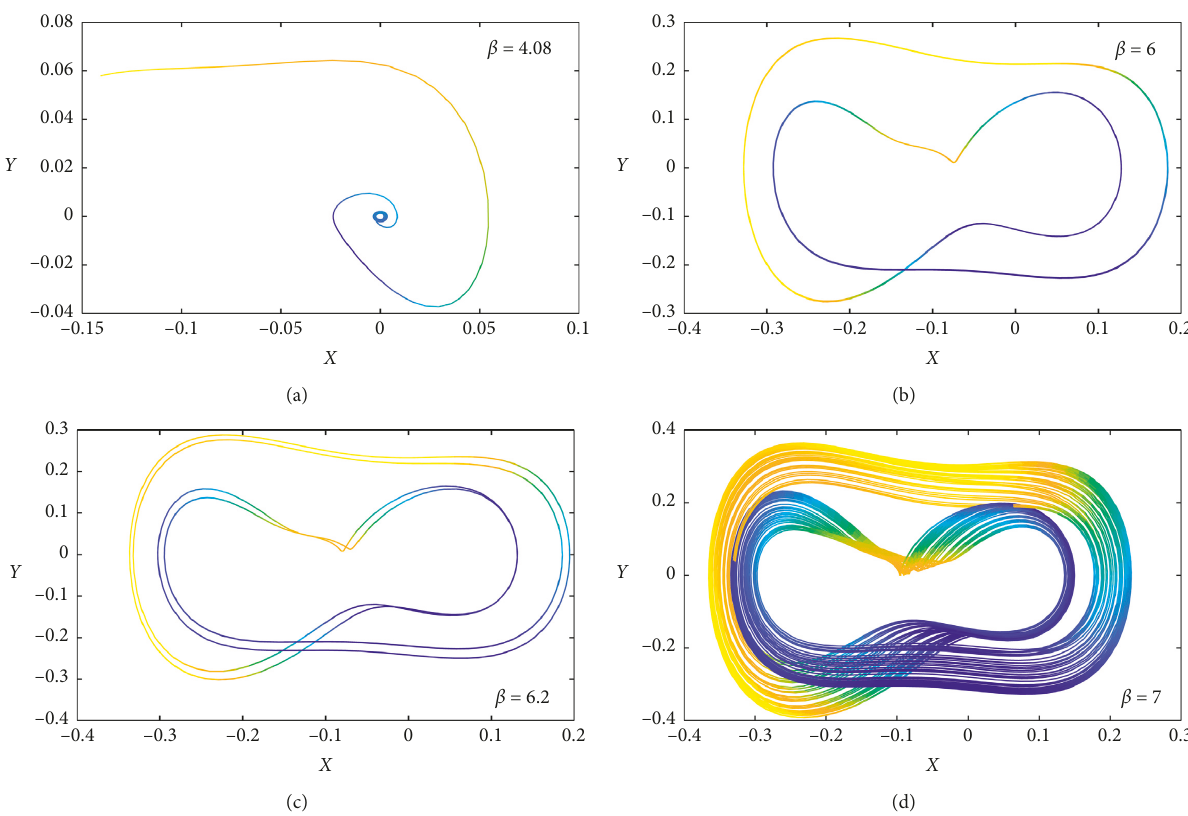
Figure 6: Phase portraits in the X - Y plane for various values of β : (a) point attractor; (b) period-1 limit cycle; (c) period-2 limit cycle; (d) chaotic